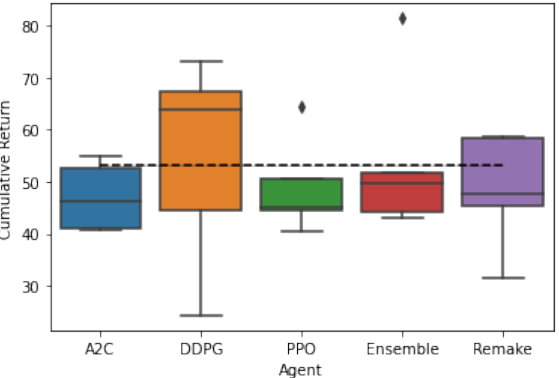
Figure 3. Cumulative returns for each agent with the DJIA (the dotted line is the benchmark index, which is the cumulative return of the